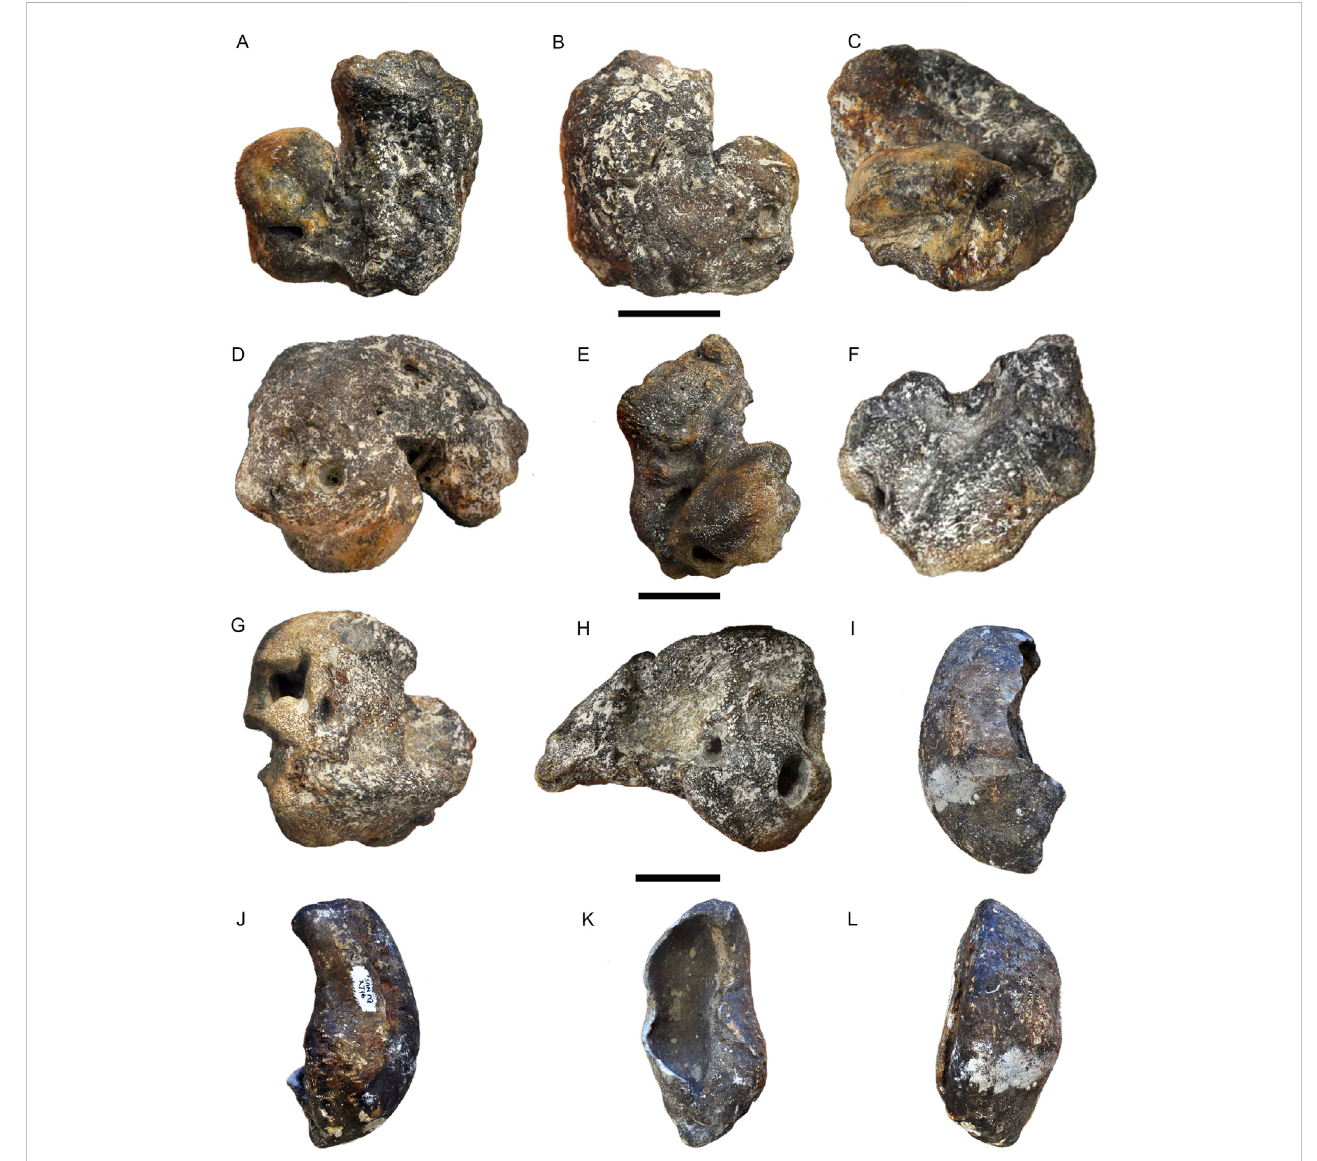
FIGURE 6 Balaenopteridaeindet.SAM-PQ-3092in (A) medial, (B) lateralview, (C) posterior,and (D) dorsalview,scale=2 cm.SAM-PQ-3087in (E) medial, (F) lateral, (G) posterior, and (H) dorsal view, scale=2 cm. SAM-PQ-2716 in (I) ventral, (J) dorsal, (K) lateral, and (L) medial view, scale=5